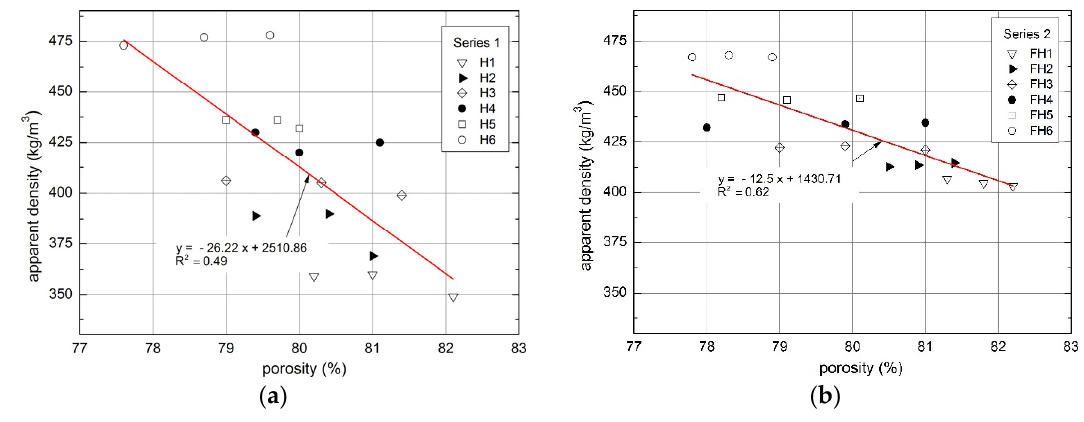
Figure 14. Dependences between composite porosity and apparent density: ( a ) Series 1; and ( b ) Series